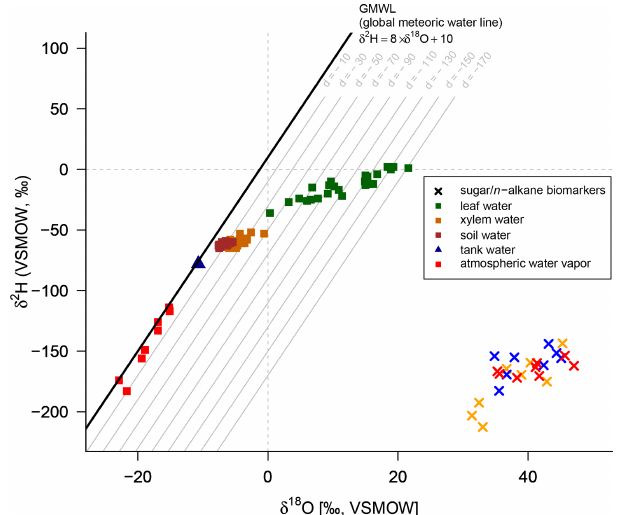
Figure 4. δ 2 H– δ 18 O diagram illustrating the isotope composition of the biomarkers: δ 2 H values of the leaf wax n -alkanes (C 29 for Eucalyptus globulus and Brassica oleracea and weighted mean of C 29 and C 31 for Vicia faba ) and δ 18 O values of the hemicellulose- derived sugars arabinose and xylose (red crosses: Brassica ol- eracea ; orange crosses: Eucalyptus globulus ; blue crosses: Vicia faba ). The measured isotope compositions of leaf water (green squares), xylem water (orange squares), soil water (brown squares), atmospheric water vapor (red squares) and the tank water used for irrigation (blue triangle), which plot very close to the global mete- oric water line (GMWL). The deuterium excess with respect to the GMWL is marked as d in per